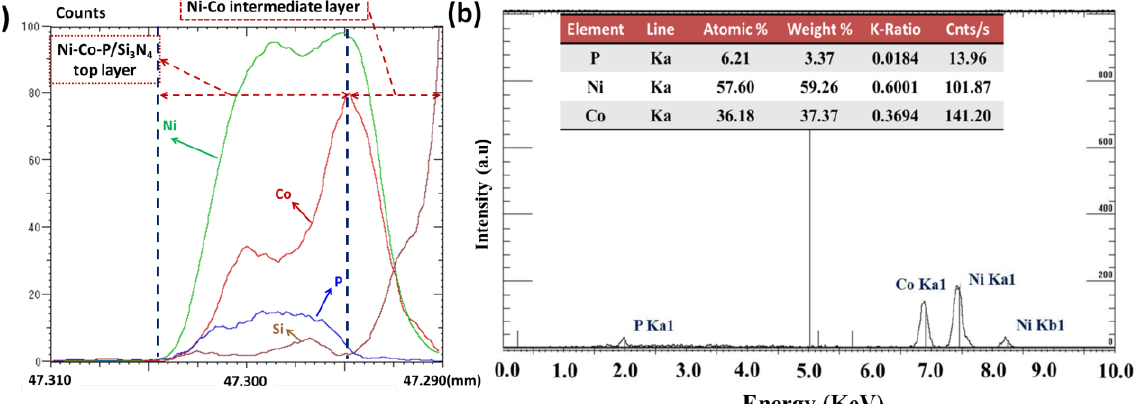
Figure 2. Elemental depth profiling across a Ni – Co – P/Si 3 N 4 composite coating over an Al – Si substrate by EPMA ( a ) and elemental composition of a Ni – Co – P/Si 3 N 4 composite coating over an Al – Si substrate by SEM/EDS ( b ).